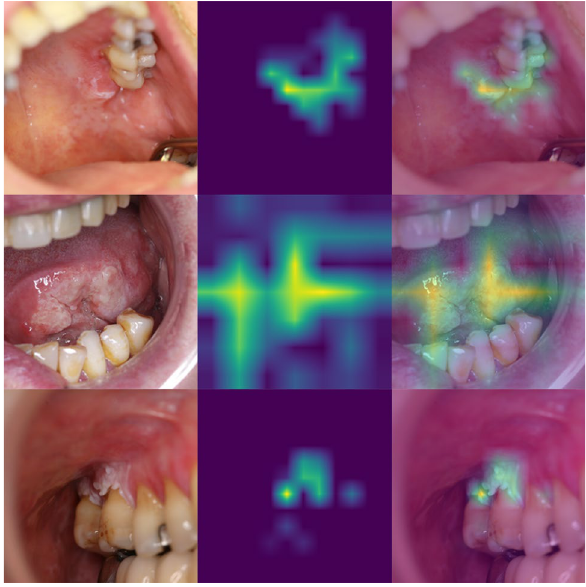
Figure 4. Class activation map for OSCC. The left column shows the CP of OSCC. The middle column represents the class activation map. The right column illustrates the overlay of CP and activation map.